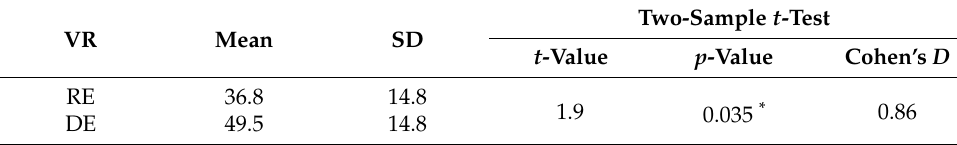
Table 3. The statistical results of TMD score for the RE and